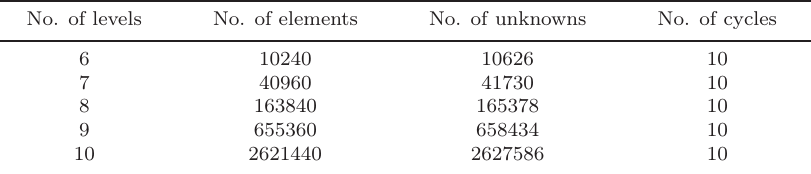
Table 2. Number of multigrid cycles for the resolution of the second numerical experiment with V(0,2) using a zebra-type smoother, for different refinement levels. No. of levels No. of elements No. of unknowns No. of cycles 6 10240 10626 10 7 40960 41730 10 8 163840 165378 10 9 655360 658434 10 10 2621440 2627586